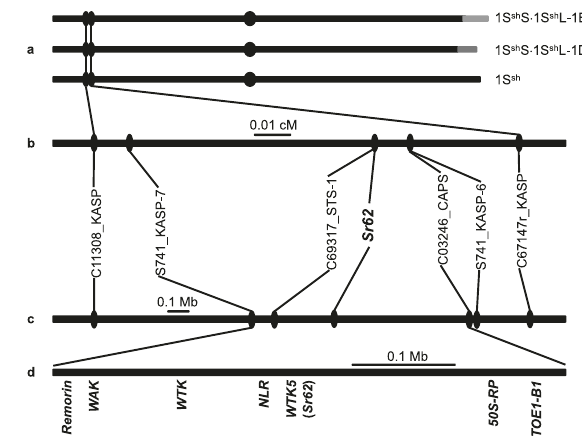
Fig. 1 Positional mapping restricts Sr62 to a 480 kb interval on chromosome 1S sh . a Wheat – Ae. sharonensis translocation chromosomes and Ae. sharonensis chromosome 1S sh . b Genetic map of the region harbouring Sr62 on the short arm of Ae. sharonensis chromosome 1S sh . c Physical map of the region around Sr62 . d Genes in the interval genetically delimiting the presence of Sr62 . WTK is presumably an ortholog of Pm24 29 .